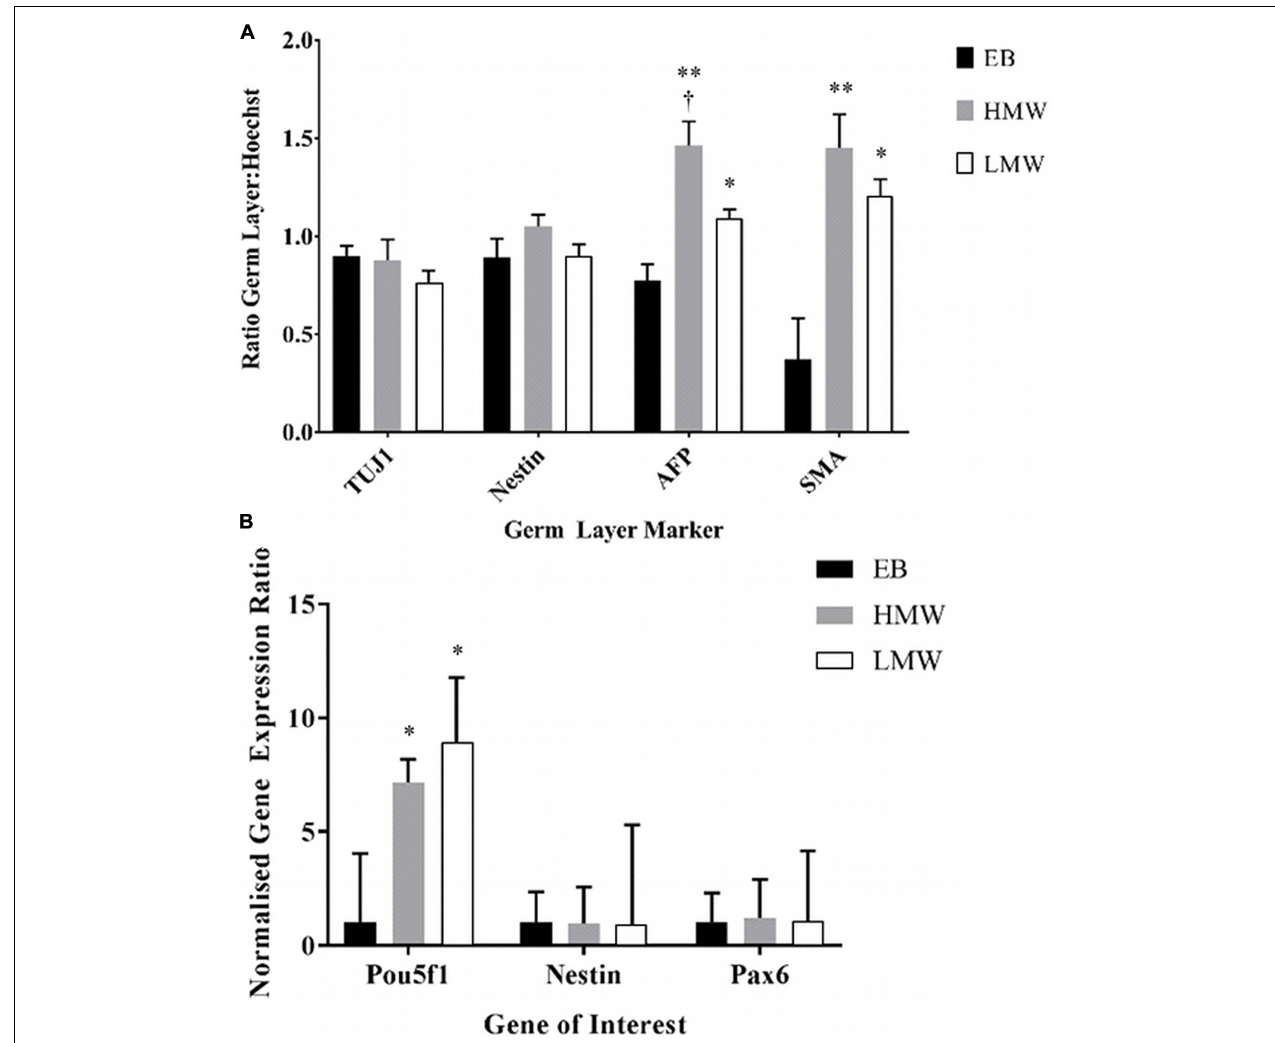
FIGURE 6 | (A) Data from pixel quantification of germ layer markers relative to nuclear stain for each differentiation condition (EB, HMW bead, and LMW bead). (B) Gene expression for neural and pluripotency markers in alginate beads and EBs. (* p < 0.05, ** p < 0.01 versus EBs, n = 3). Data from three experiments ( n = 3 samples in each) and presented as mean and SEM. † indicates statistical significance ( p < 0.05) versus LMW beads.